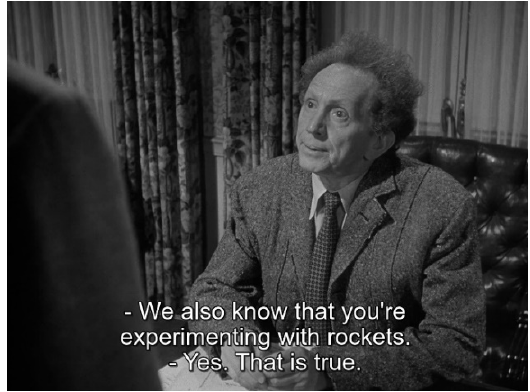
Figure 5. Klaatu’s experimental rocketry comment. The Day the Earth Stood Still © 20th Century Fox. All Rights Reserved.